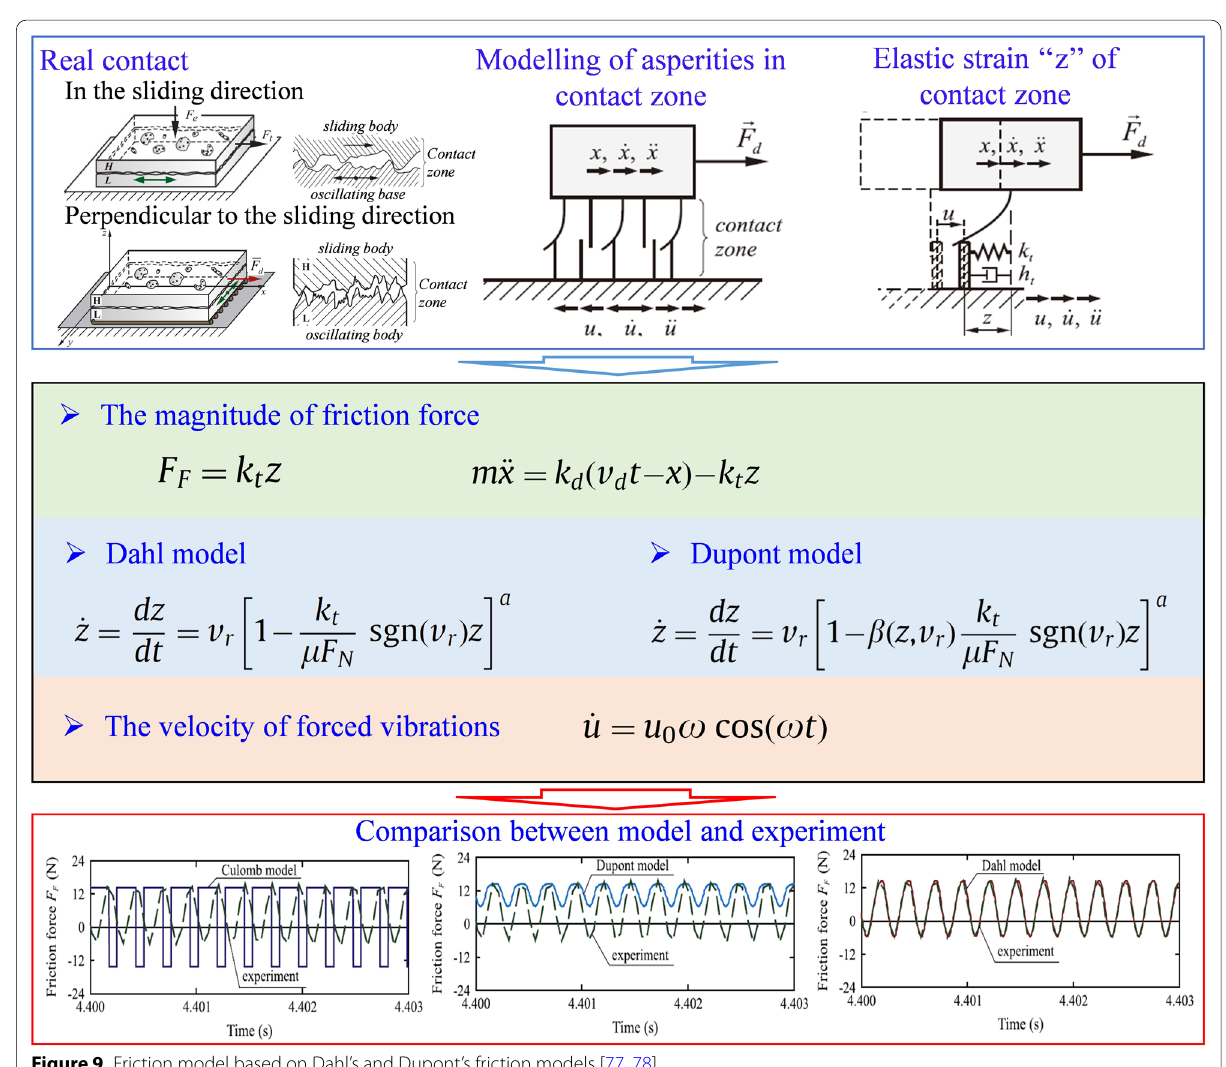
Figure 9 Friction model based on Dahl’s and Dupont’s friction models [77,